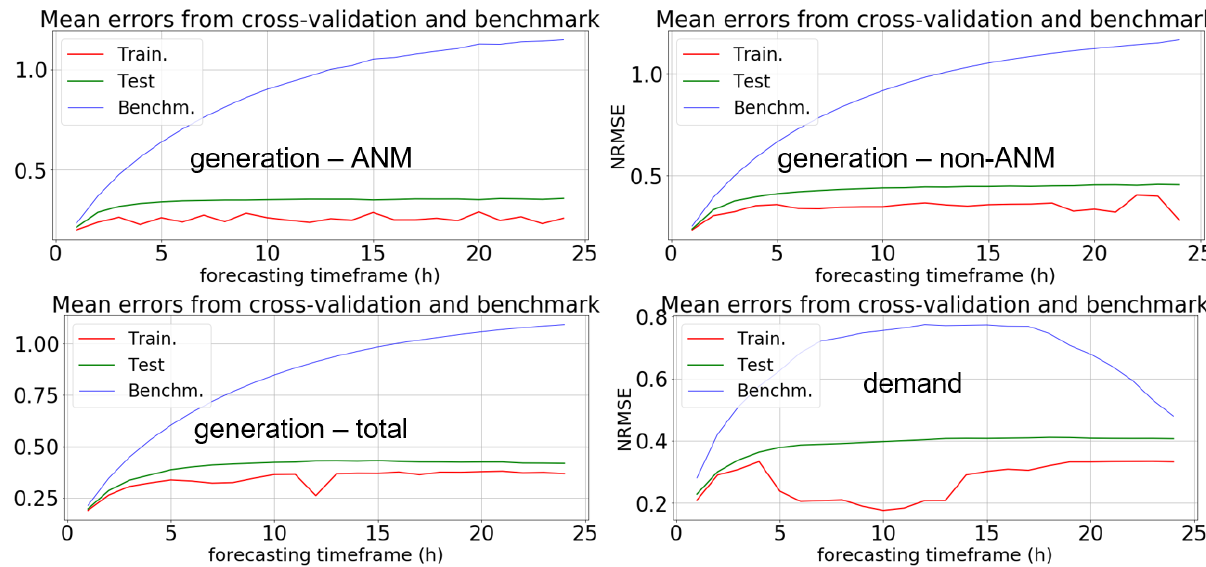
Figure 3. NRMSE per forecasting horizon corresponding to the selected models for Orkney.